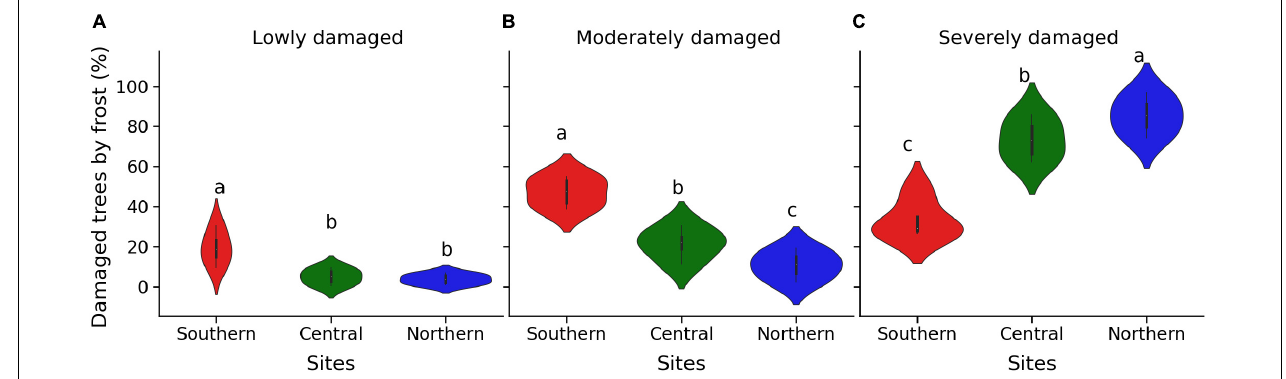
FIGURE 5 | Violin plots of the rate of damaged trees (%) during the late-spring frost of 2021 in the three plantation test sites. (A) Lowly damaged, (B) moderately damaged, and (C) severely damaged. The violin plot combines a box plot and density plot. The box ends indicate the upper (third) to lower (first) quartiles of the value ranges, and the whiskers indicate the highest and lowest observations. Means with the same letter indicate no significant differences with P ≥ 0.05.